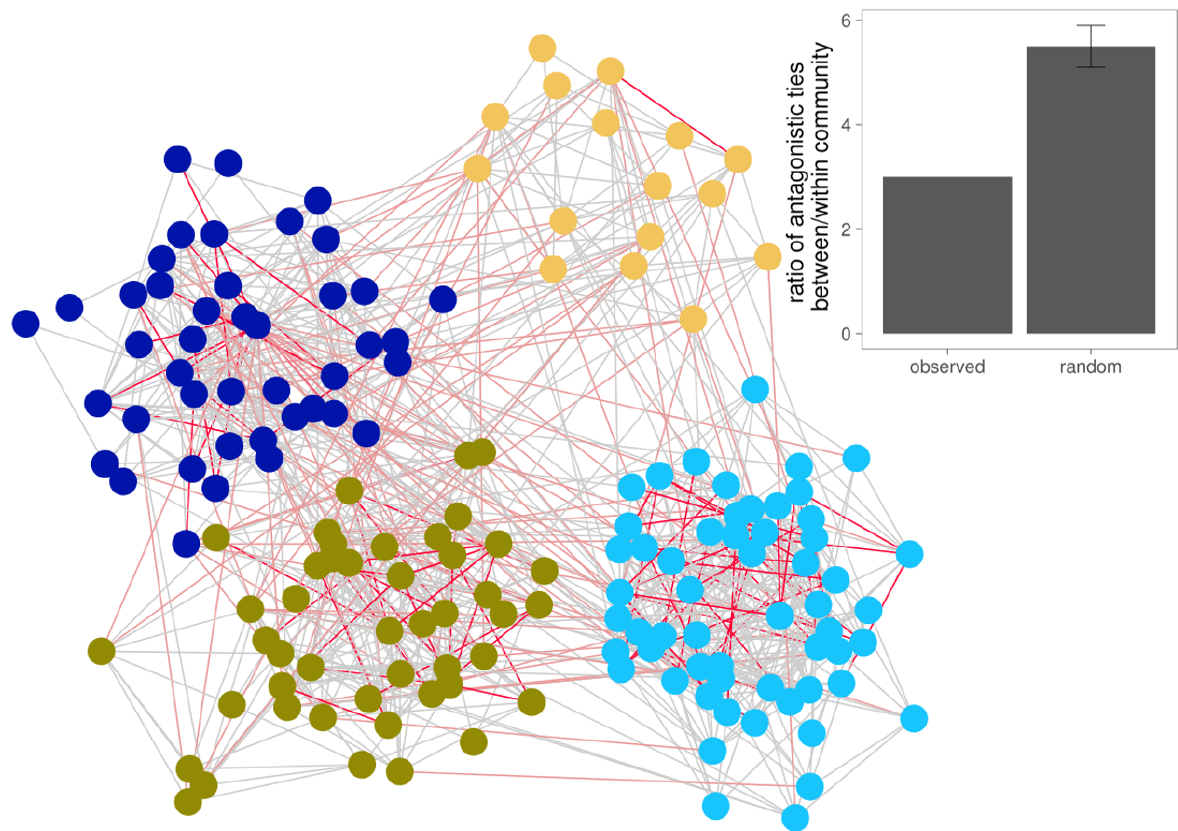
Figure 5: Illustration of between-community versus within-community ties. In this network from one village (N = 162 people), node colors represent distinct communities detected by a fast-greedy algorithm, gray ties represent friendship, light-red ties represent between-community antagonistic ties, and dark-red ties represent within-community antagonistic ties. In the observed data, there are three times more antagonistic ties between communities than within communities. But this is less than we would expect due to chance, suggesting that frequent social contact within communities may contribute to the formation of antagonistic ties. The inset shows the real mean ratio (left bar) compared to the mean and 99.5 percent confidence interval of more than 1,000 sets of 176 random networks of villages (right bar; see the Methods